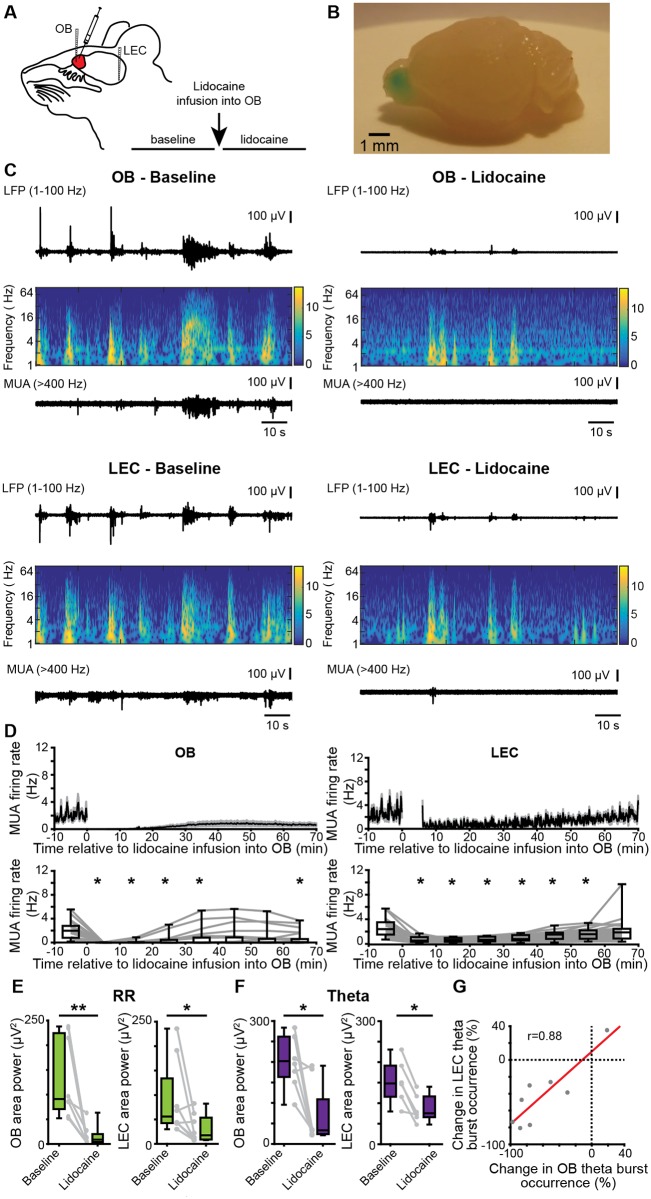
Effects of pharmacological blockade of neuronal firing in OB on patterns of oscillatory activity in OB–LEC circuits.(A) Schematic drawing of experimental protocol. (B) Photograph of the brain of a P10 mouse showing the confinement of injections to one hemisphere of the OB. For visualization, the same volume of methylene blue was used. (C) Characteristic LFP traces (black, filtered 1–100 Hz) recorded in OB (top) and LEC (bottom) of a P9 mouse before (left) and after (right) lidocaine infusion, displayed together with the wavelet spectrograms of the LFP and simultaneously recorded MUA. (D) Top, mean MUA firing rate in OB (left) and LEC (right) before and after lidocaine infusion. The time of infusion is considered 0. Bottom, box plots displaying the mean MUA in OB (left) and LEC (right) before and after lidocaine infusion (Friedmann test, Wilxocon signed-rank test with Bonferroni correction for post hoc comparison, *p < 0.0071). (E) Box plots displaying the power of RR activity in OB and LEC in the RR band before and after lidocaine infusion. Gray dots and lines correspond to individual animals (Wilcoxon signed-rank test, *p < 0.05; **p < 0.01). (F) Same as E for the theta burst activity in neonatal OB and LEC. (G) Scatterplot displaying the relationship between the occurrence changes (percent of baseline) of OB and LEC theta bursts (r = 0.008, p = 0.0039, Pearson correlation). Data are available in S1 Data. LEC, lateral entorhinal cortex; LFP, local field potential; MUA, multiunit activity; OB, olfactory bulb; P, postnatal day; RR, respiration-related rhythm.